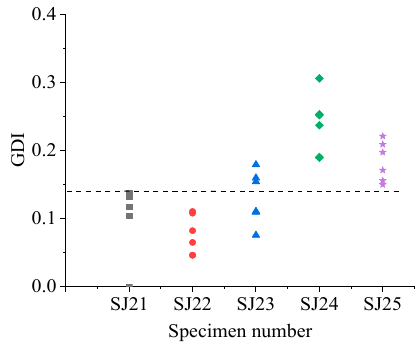
Figure 12. GDI of specimens in the SJ2 group.